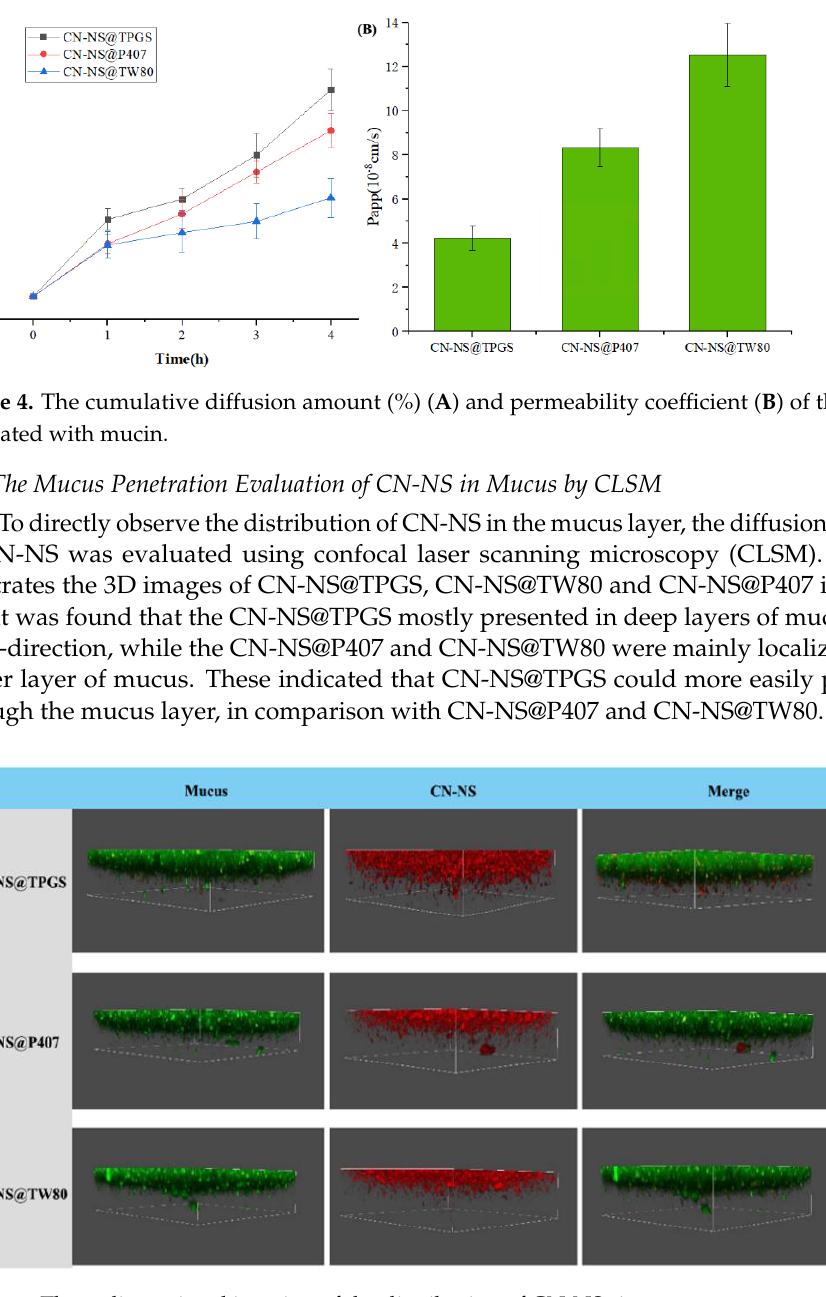
8 of 15 Figure 3. the changes in Zeta potential ( A ) and particle size ( B ) of the CN-NS incubated with mucin. 3.3. The Mucus Penetration Ability of CN-NC in Mucus The ability of different CN-NSs to penetrate through the mucus layer was quantified using a transwell system. Figure 4A shows the cumulative penetrating ability of different CN-NS in the mucus. Figure 4B displays the Papp values of different CN-NS in the mucus.